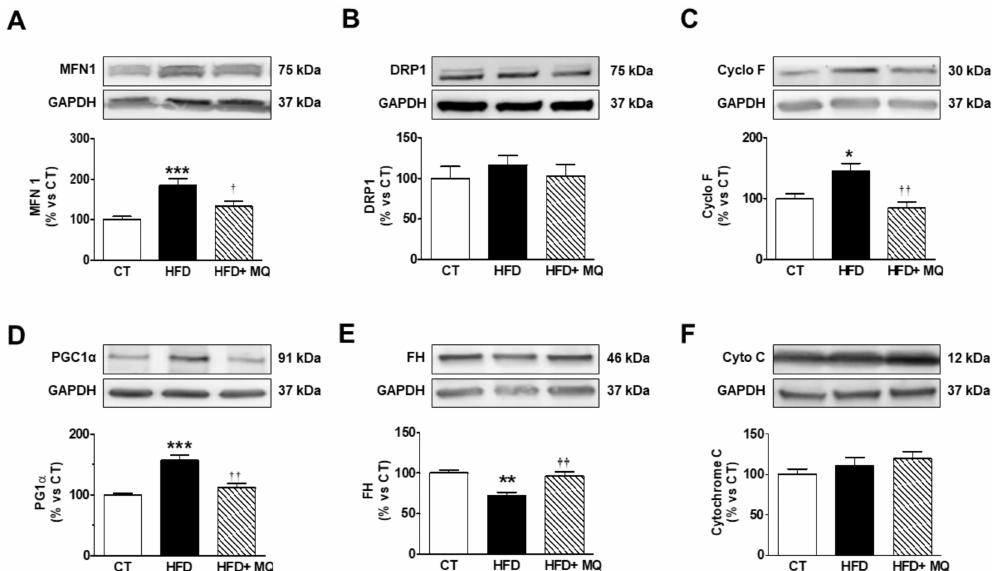
Figure 5. Impact of the mitochondrial antioxidant MitoQ (MQ) on mitochondrial protein levels in the hearts of obese rats. Hearts from rats fed a standard diet (CT) or a high fat diet (HFD) treated with vehicle or with MQ (200 µ M) were analyzed. Protein expression of ( A ) mitofusin 1 (MFN1), ( B ) Dynamin-1-like protein (DRP1), ( C ) cyclophilin F (Cyclo F), ( D ) peroxisome proliferator-activated receptor gamma coactivator 1-alpha (PGC-1 α ), ( E ) fumarate hydratase (FH) and ( F ) cytochrome C are presented. Bar graphs represent the mean ± SEM. of 6–8 animals normalized to glyceraldehyde-3-phosphate dehydrogenase (GAPDH). * p < 0.05; ** p < 0.01; *** p < 0.001 vs. control group. † p < 0.05; †† p < 0.01 vs. HFD group.